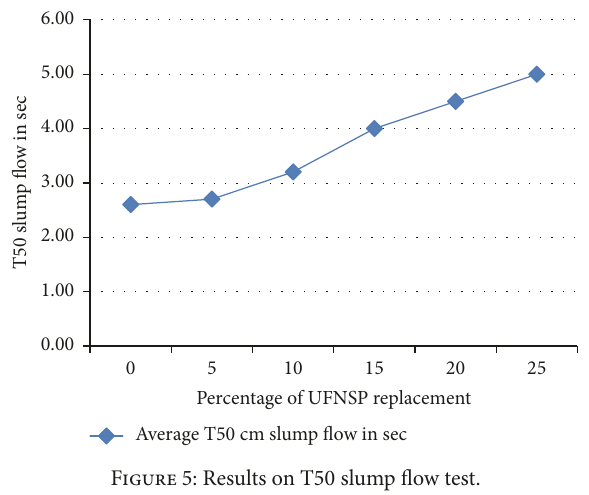
Figure 5: Results on T50 slump flow test.